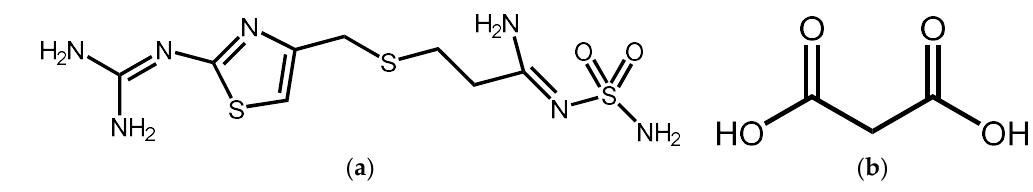
Figure 1. Structures of ( a ) FMT and ( b ) MAL.